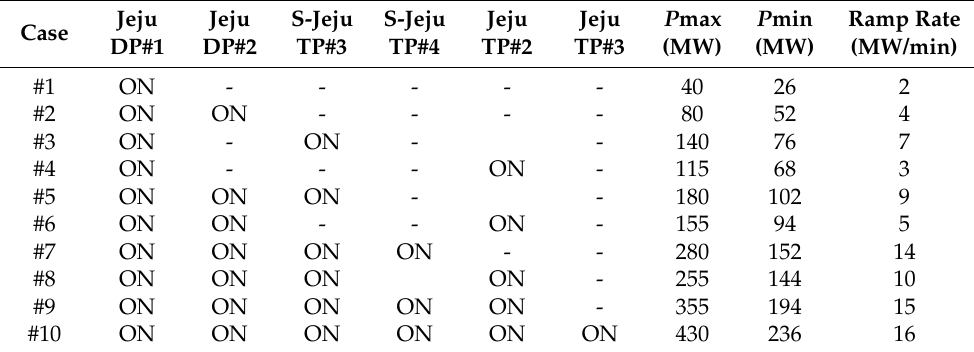
Table 3. Jeju Island generator in-service cases.